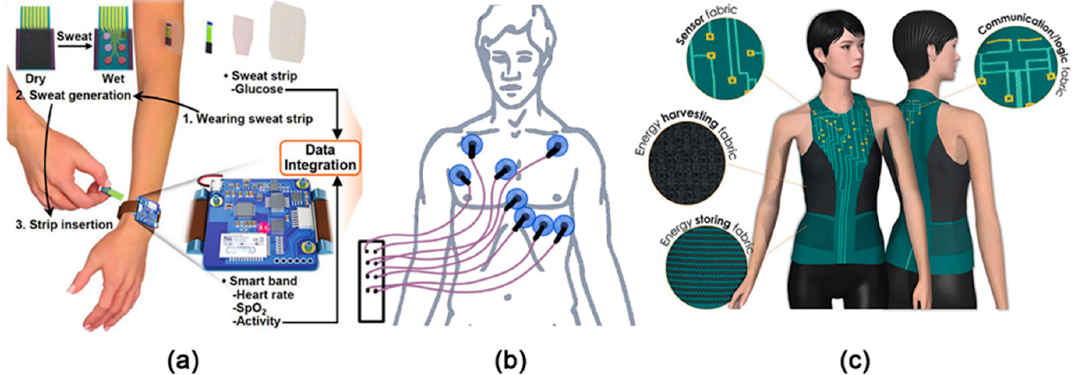
Figure 10. Examples of wearable electronics. Band, patch [206] ( a ), sample of electrode array for ECG, EEG, EOG and EMG ( b ), and for e-textile [214] ( c ). Reproduction permissions were obtained from John Wiley and Sons.